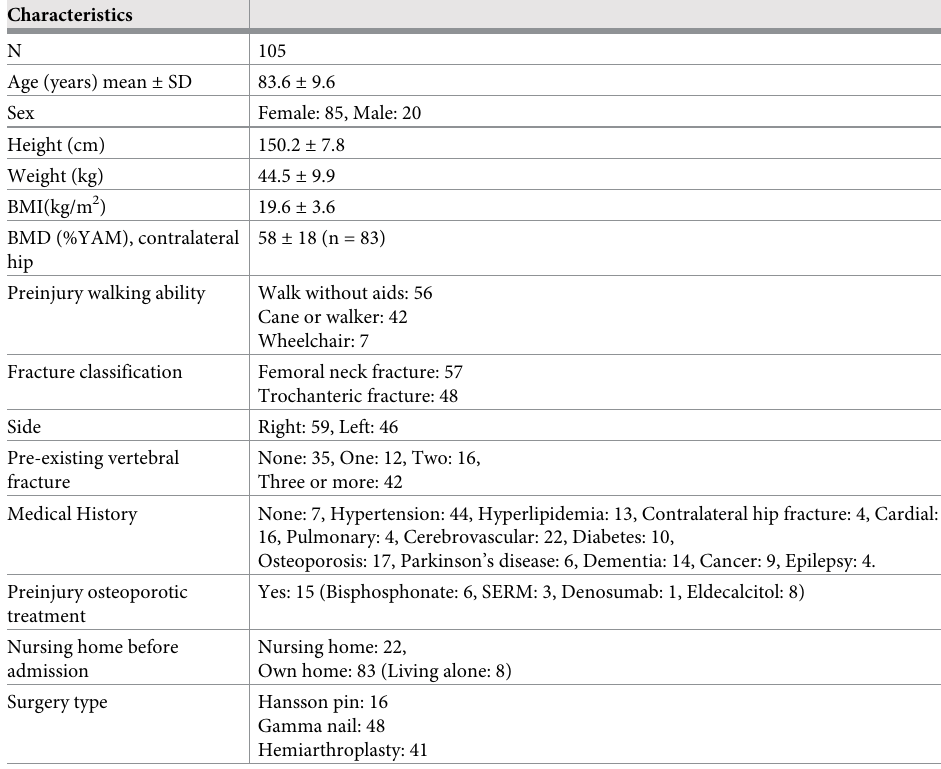
Table 1. Demographic and clinical characteristics of the study